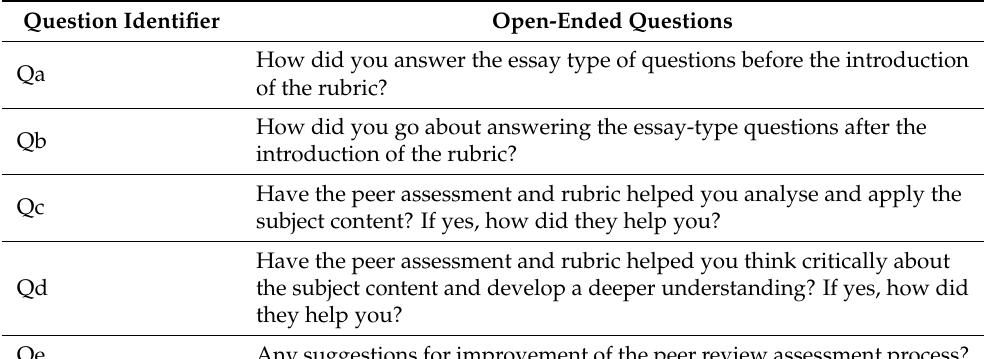
Table 1. Open-ended questions.